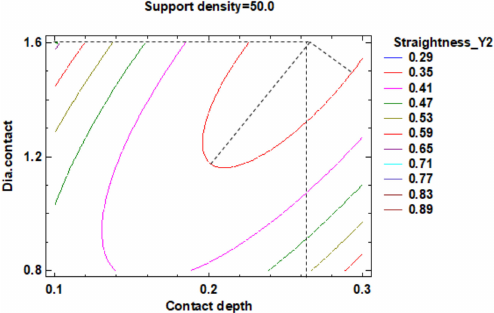
Figure 28. Contours of Estimated Response Surface for Straightness_Y2 and centre support